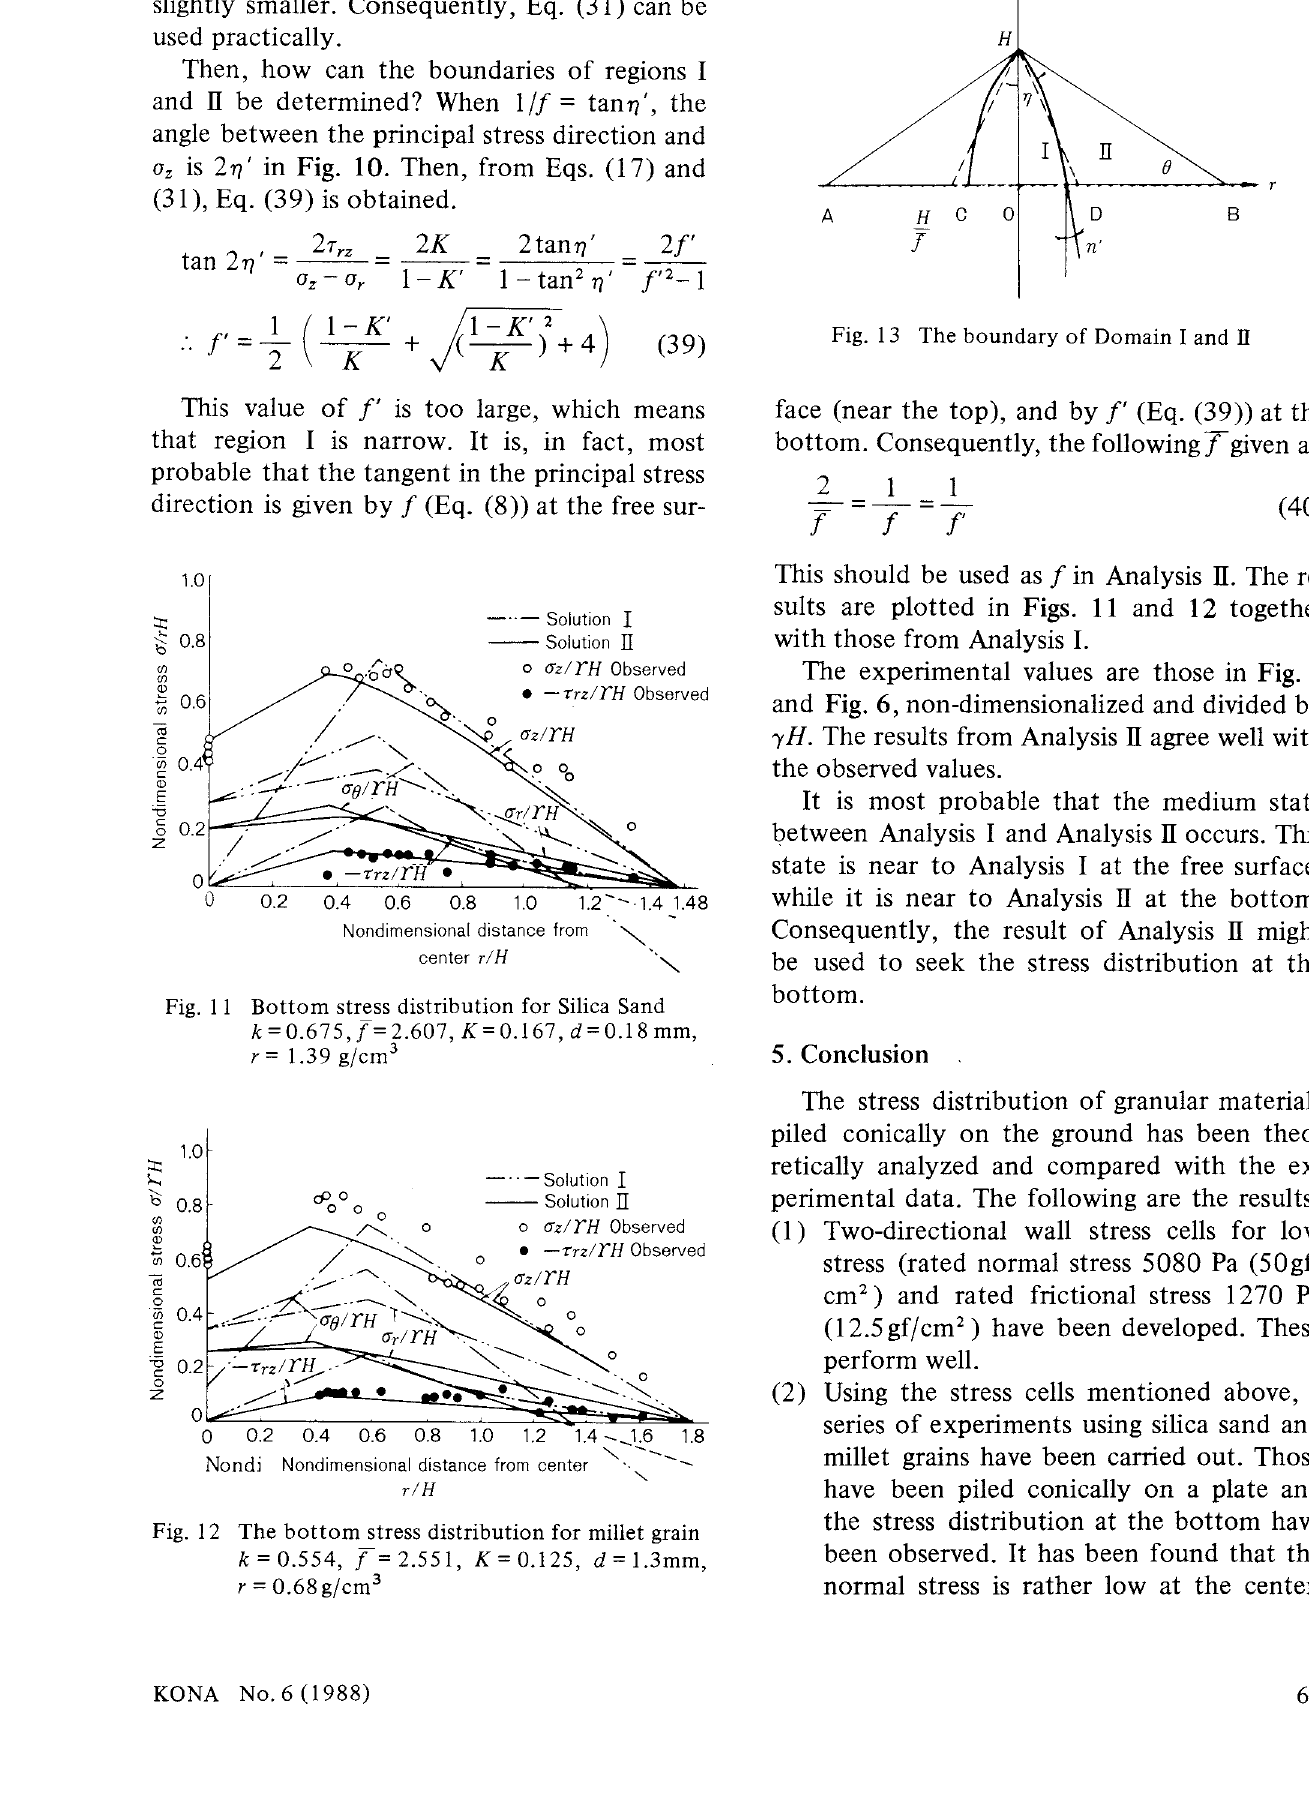
Fig. 13 The boundary of Domain I and